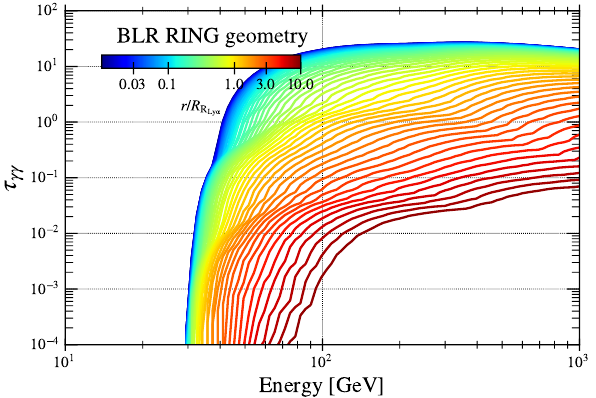
Figure 8. The optical depth τ γγ as a function of γ -ray energy in the incident photon field of the BLR. The colors refer to different distances r along the jet with respect to the distance R Ly the Ly α